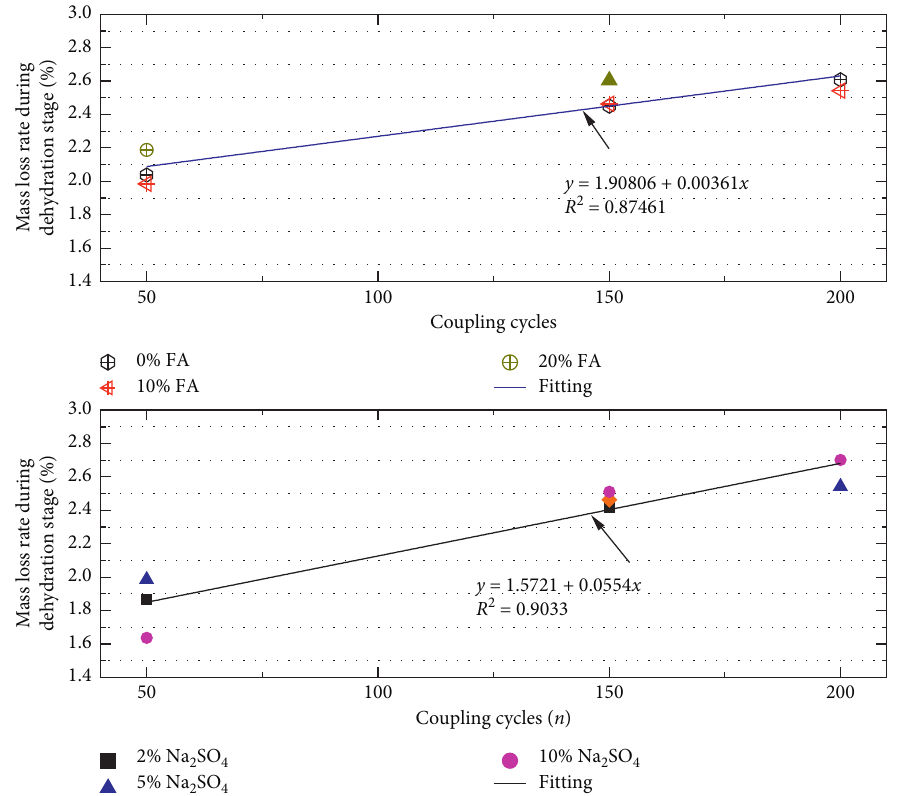
Figure 15: The relationship between mass loss rate and coupling cycle during the dehydration stage of corrosion products (60 ° C–130 °